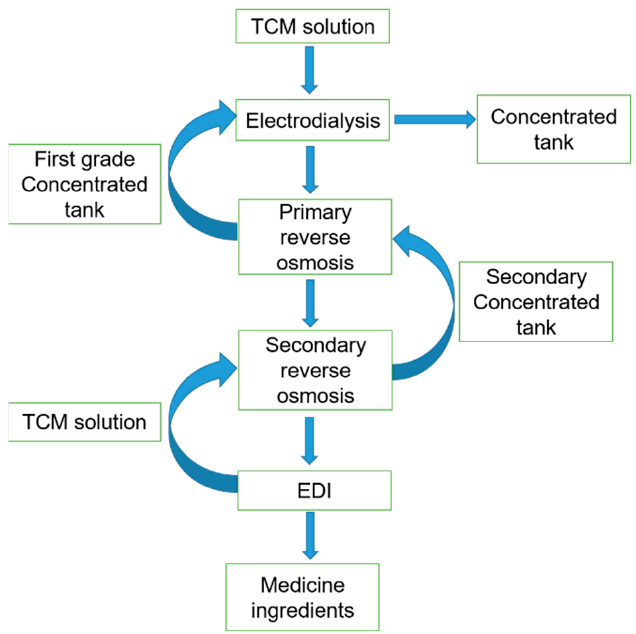
Figure 6. Electrodialysis process for TCM concentration process.